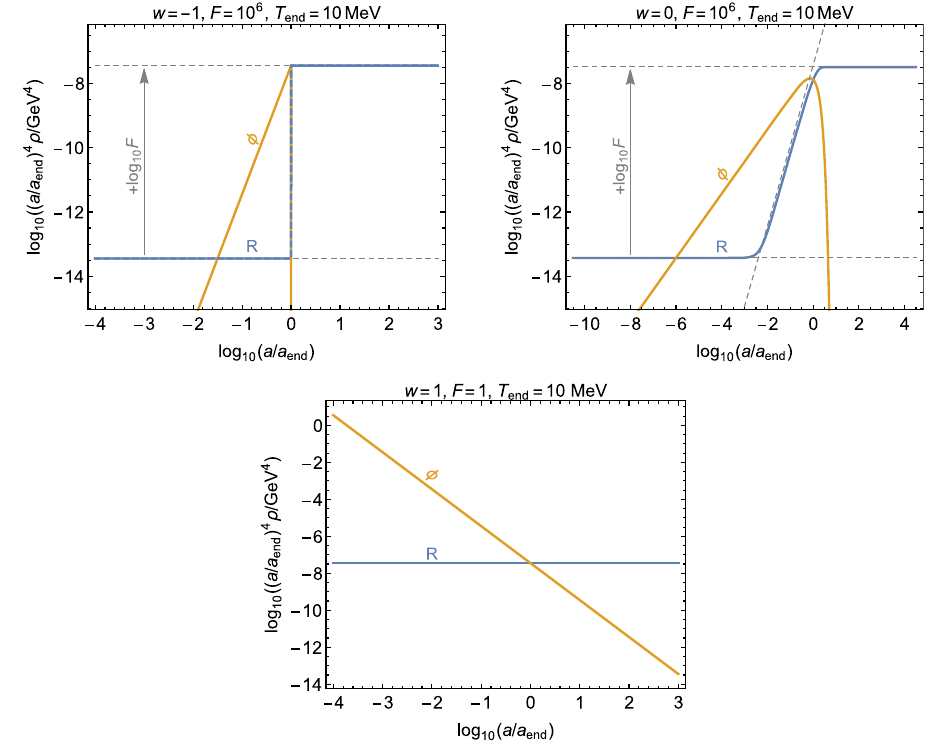
Fig. 1 The solid yellow lines show the evolution of ρ φ for w = − 1, 0, 1 (upper left, upper right and lower panels, respectively), and the blue lines show the evolution of ρ R . Here a end ≡ a ( T = T end ) denotes the value of the scale factor a when the ρ φ dominance ends and the usual radiation-dominated phase